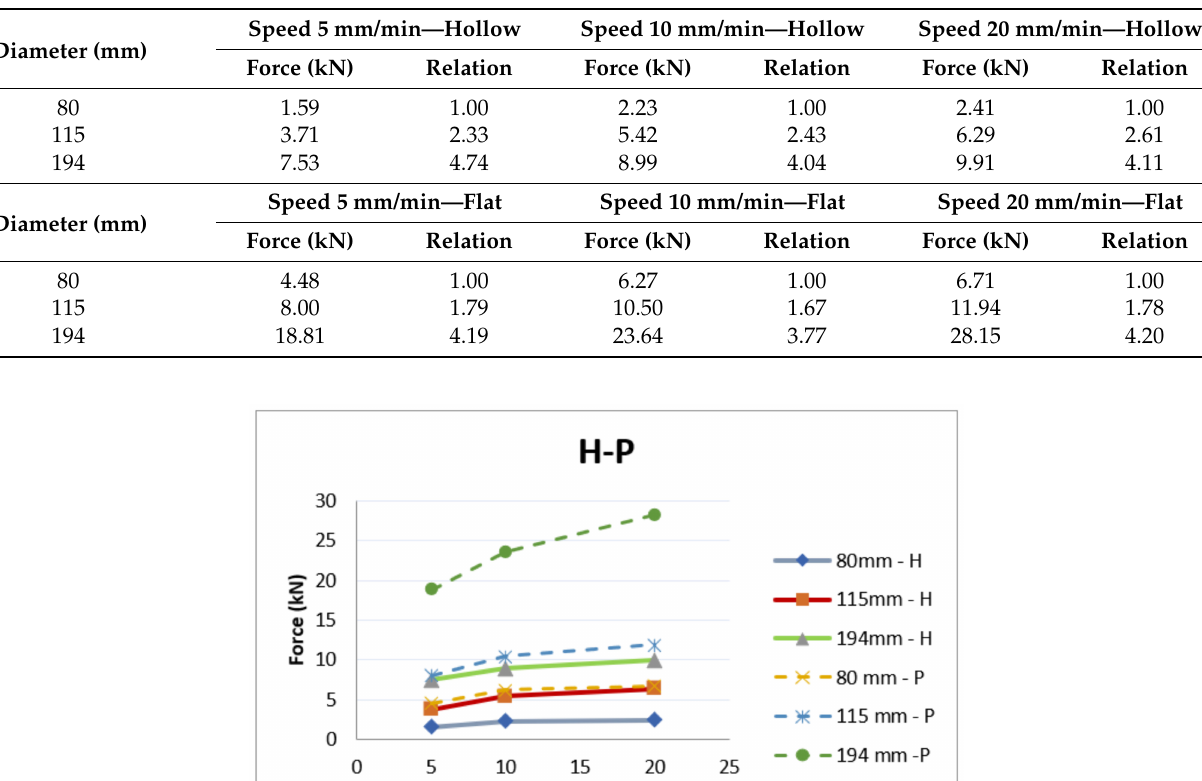
Table 6. Values of penetration force for all scale tests as a function of diameter.